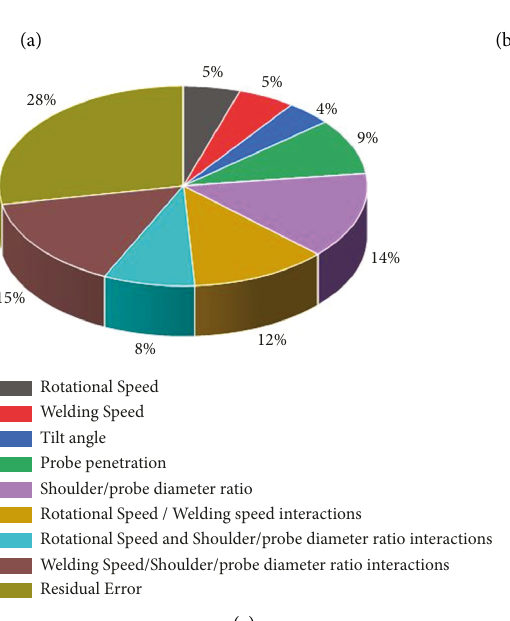
Figure 3: Percentage of the contribution of the significant parameters determined from ANOVA analysis for each joint configuration. (a) Butt joint. (b) T joint. (c) Lap